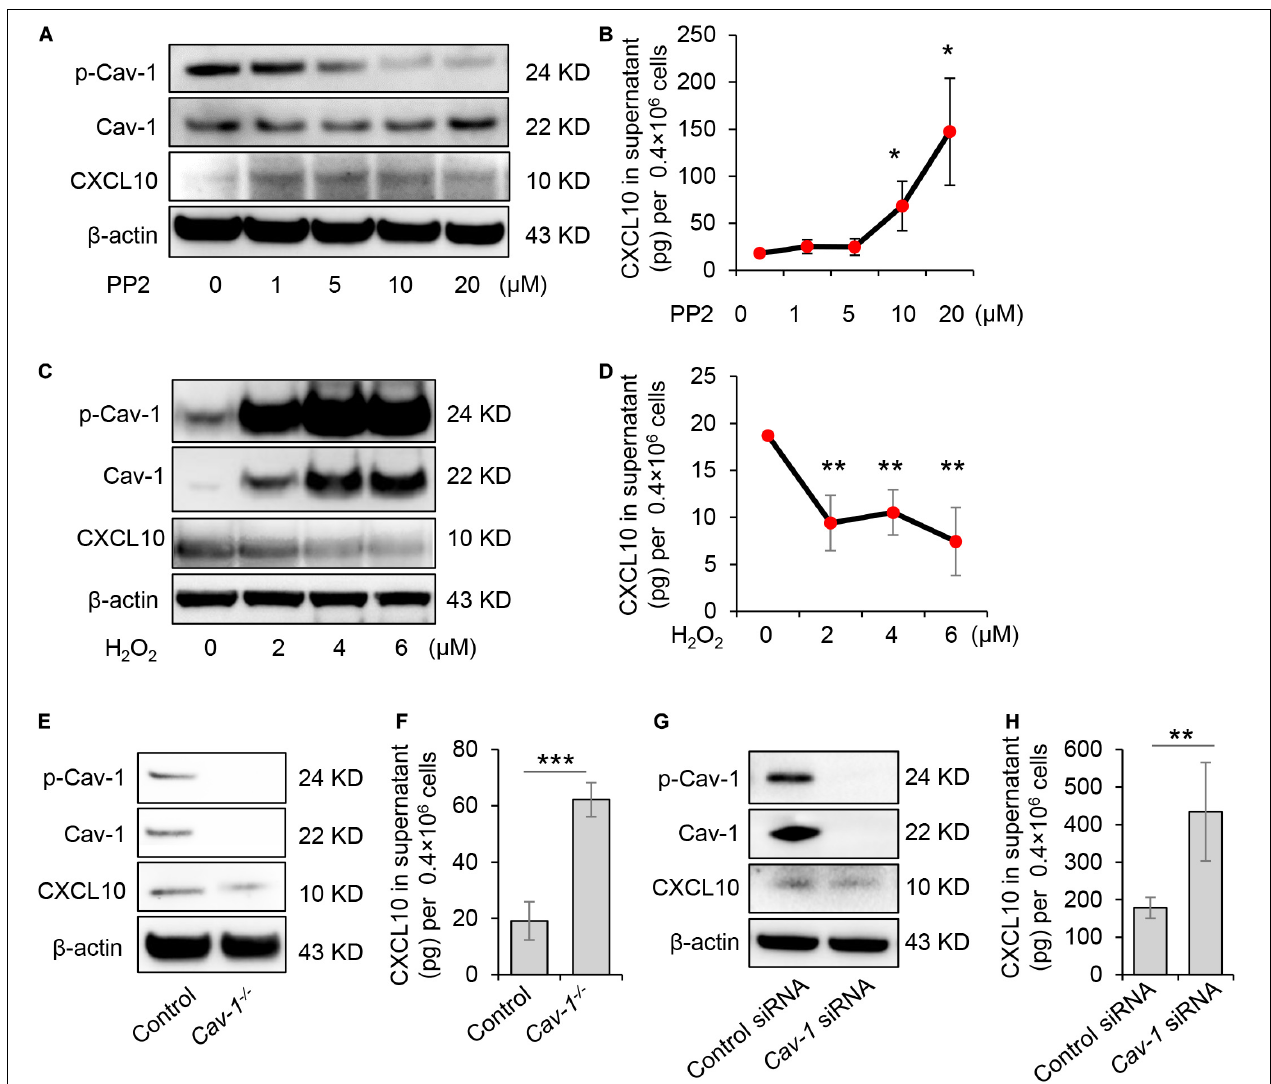
FIGURE 3 | Dephosphorylation of Cav-1 controlled CXCL10 secretion in murine GMSCs. (A) Western blotting analysis showed cytoplasmic protein expression of p-Cav-1, Cav-1, and CXCL10 of GMSCs treated with different dose of PP2 for 2 h. (B) ELISA analysis of CXCL10 secretion in the culture supernatant from GMSCs treated with different dose of PP2 for 24 h. * P < 0.05 compared with control group. (C) Western blotting analysis showed cytoplasmic protein expression of p-Cav-1, Cav-1, and CXCL10 of GMSCs treated with different dose of H 2 O 2 for 0.5 h. (D) ELISA analysis of CXCL10 secretion in the culture supernatant from GMSCs treated with different dose of H 2 O 2 for 24 h. ** P < 0.01 compared with control group. (E) Western blotting analysis showed absent expression of Cav-1 and p-Cav-1 and decreased cytoplasmic CXCL10 in Cav-1 - / - GMSCs. (F) Knocking out of Cav-1 elevated CXCL10 secretion into the culture supernatant of GMSCs as analyzed by ELISA. *** P < 0.001 compared with WT GMSCs control. (G) Western blotting analysis confirmed the efficiency of Cav-1 siRNA, and showed that knocking down of Cav-1 decreased cytoplasmic CXCL10 in GMSCs. (H) Knocking down of Cav-1 elevated CXCL10 secretion in the culture supernatant of GMSCs as analyzed by ELISA. ** P < 0.01 compared with GMSCs treated with control siRNA. All results are representative of data generated in at least three independent experiments. Error bars are means ± SD. Data were analyzed using independent unpaired two-tailed Student’s t -tests or one-way